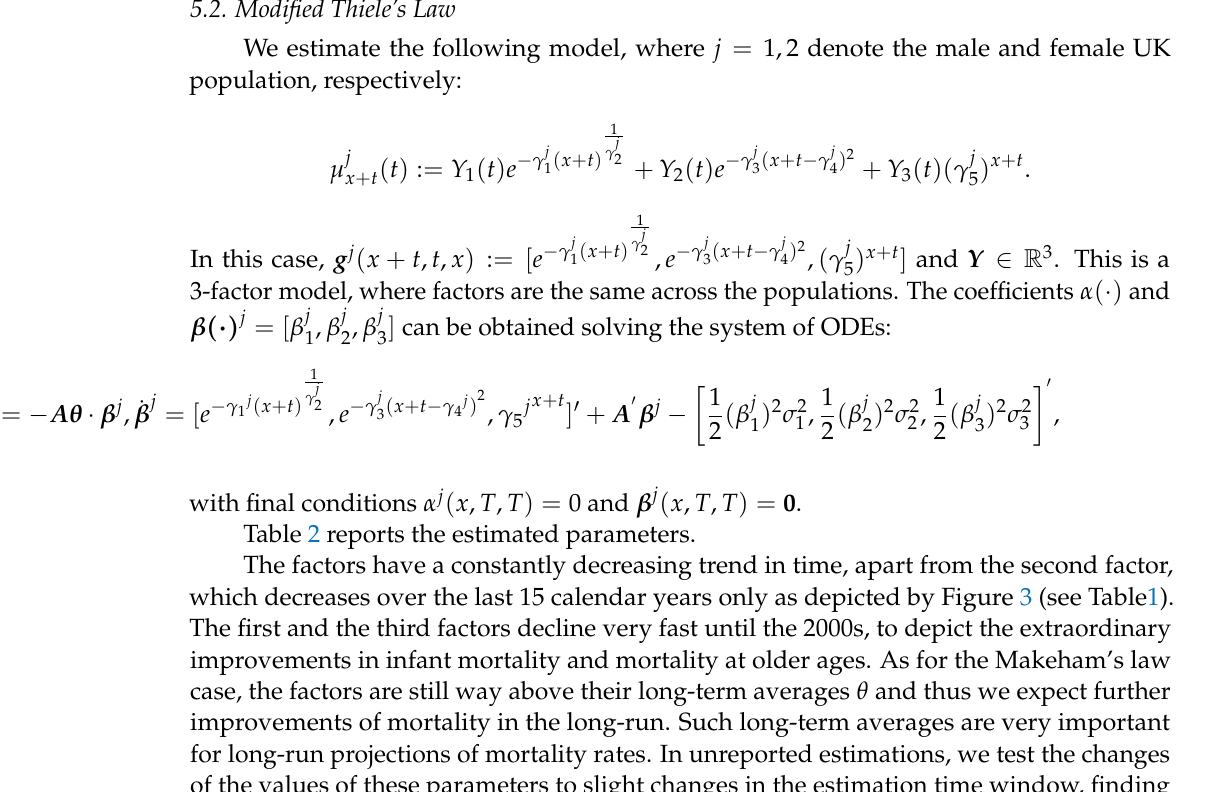
Figure 2. The figures plot the values of the MARE for female and male ages and averaged over calendar